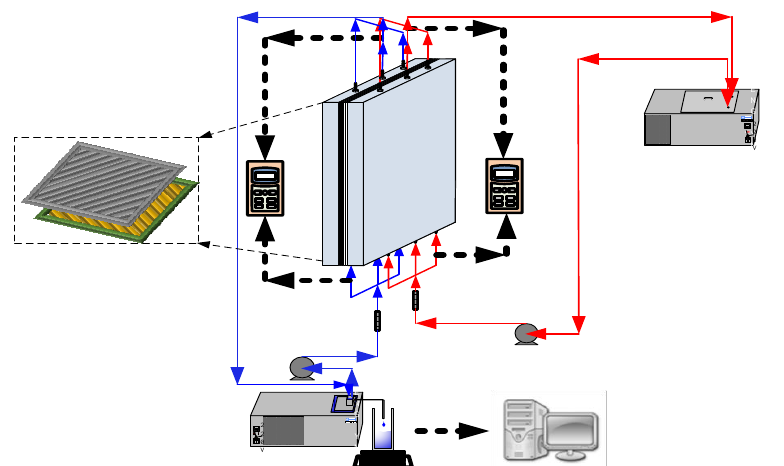
Figure 14. Schematic diagram of the experimental setup for the DCMD system of the channels with inserting diagonal carbon-fiber spacers.